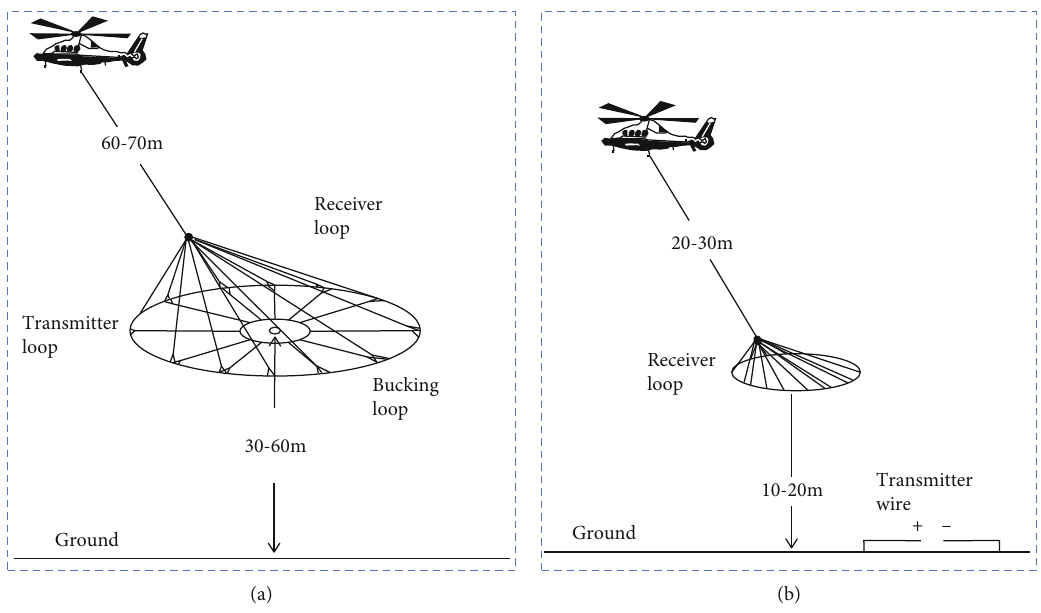
Figure 14: Schematic diagram of (a) airborne TEM and (b) semiairborne TEM